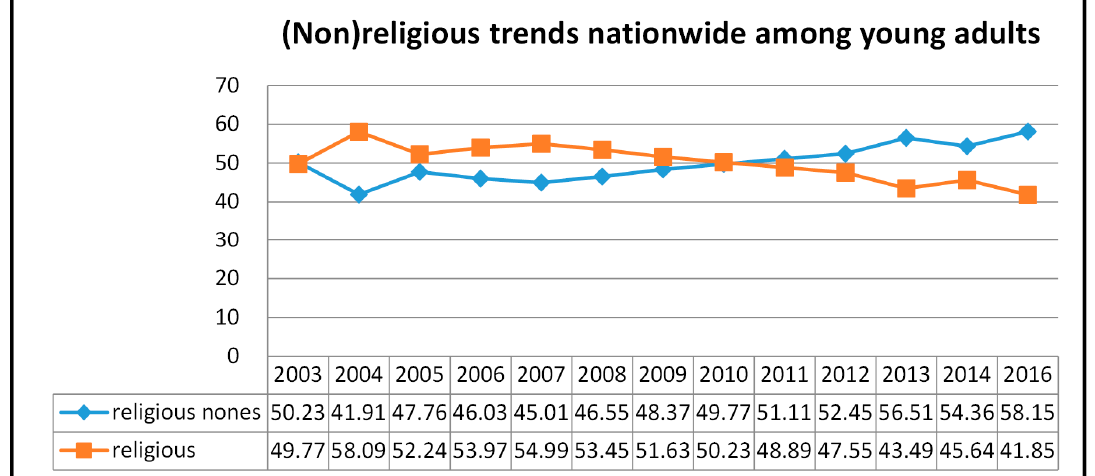
Figure 1. Nationwide trends among young adults (aged 18–39): 2003–2016. (%). Source: Korean General Social Survey (KGSS) 2003~2016.